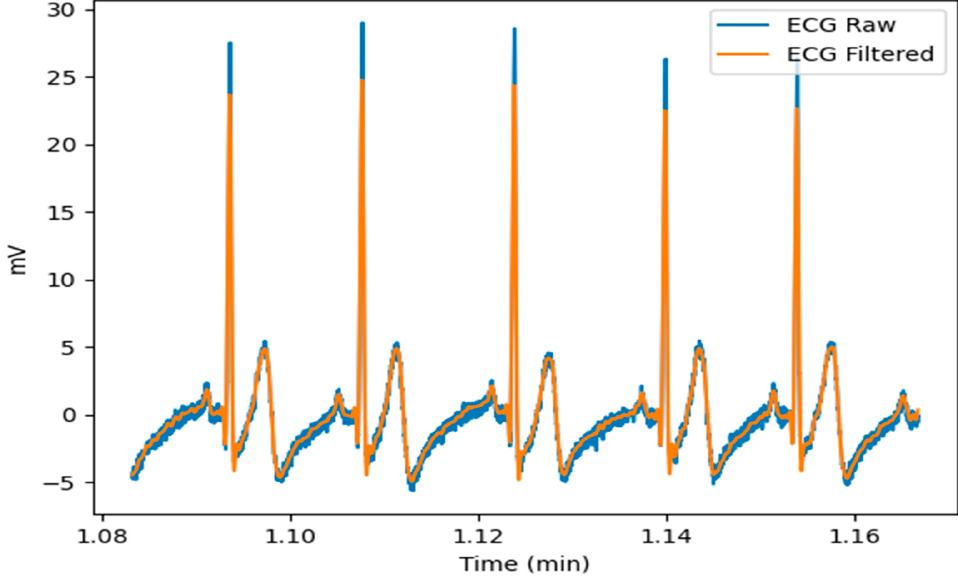
Figure 4. Overlay of filtered signal and original.